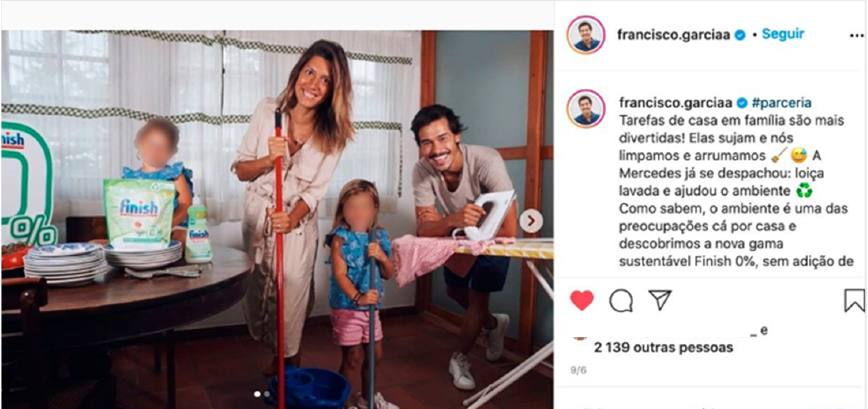
Figure 12. Example of speech—“Advertising or Partnership”; Instagram @francisco.garciaa, Post, 9